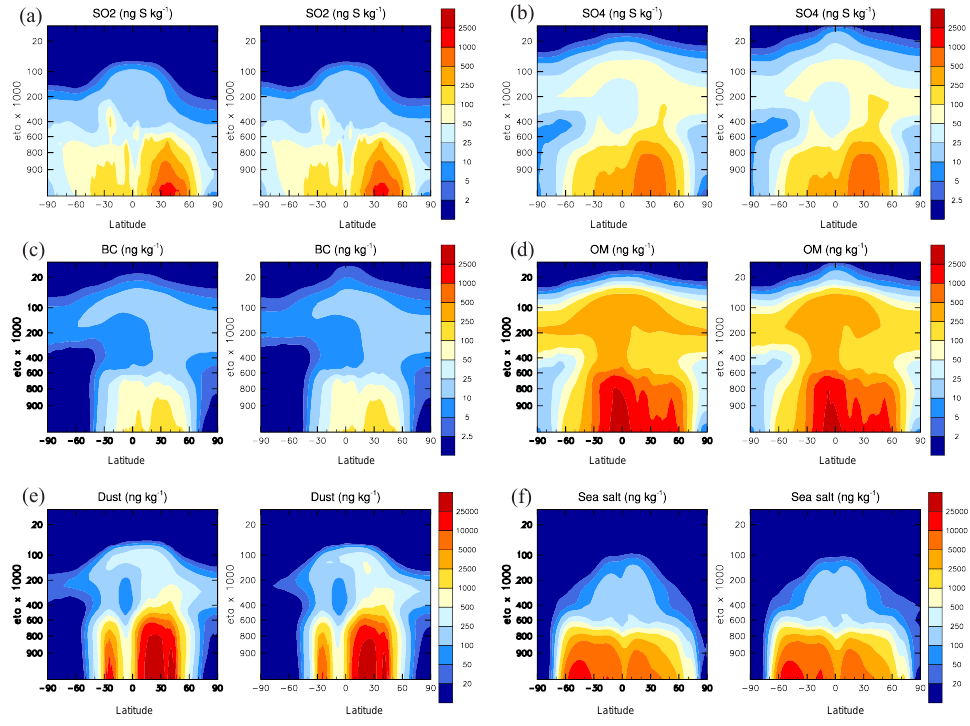
Figure 4. Modeled zonal mean mass mixing ratios of (a) SO 2 , (b) sulfate (as S), (c) BC, (d) OM, (e) dust, and (f) sea salt in the NUDGE_PD (left panels) and the AMIP_PD (right panels) simulation (eta × 1000 is the model hybrid coordinate eta level multiplied by 1000). Note the different scales for mineral dust and sea salt vs. the other components.